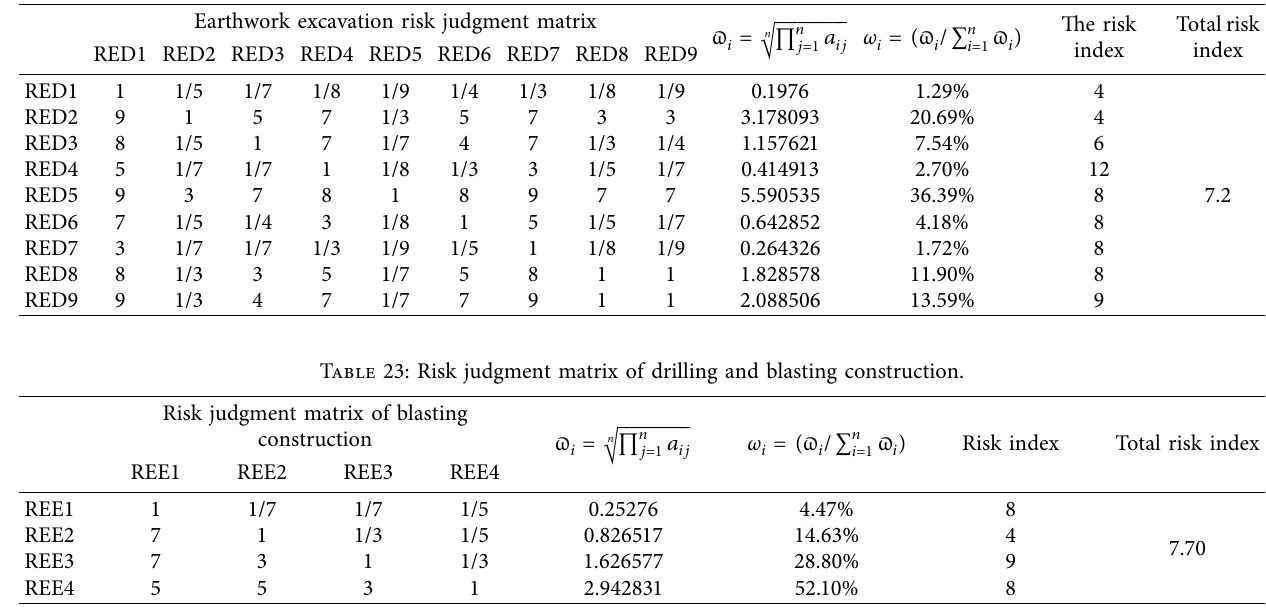
Table 22: Earthwork excavation risk judgment matrix.